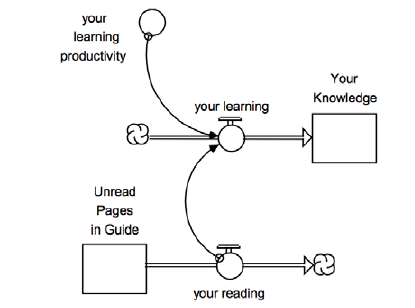
Figure 2. Example of a causal-loop diagram (source: Sterman, 2000, p. 138)